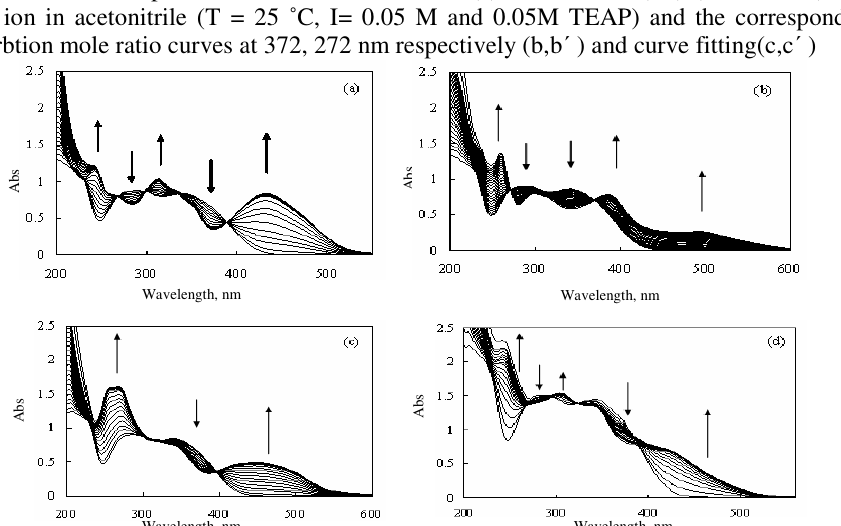
Figure 3 . Uv-Vis spectra for titration of BSNPHEN (3.8 × 10 -5 M) with metal ions (1.0 × 10 -3 M)